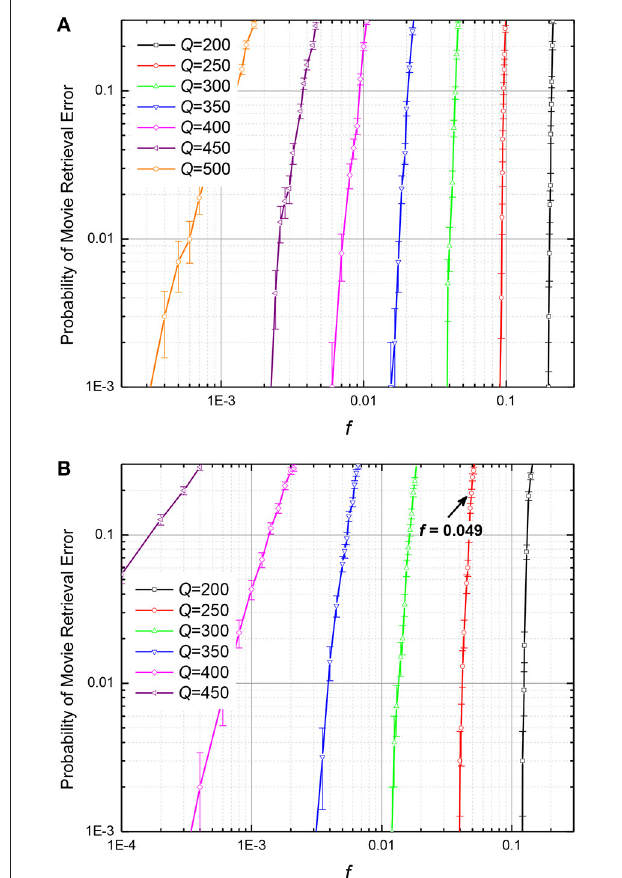
FIGURE 10 | The probability of movie retrieval error at: (A) the quadratic-programming recording, and (B) the discrete gradient-descent recording, as functions of the fraction f of wrong (randomly flipped) binary pixels in the input frame, for M 440. The arrow shows the point with = f 0.049, which corresponds to the case illustrated in Figure 12 . The error = bars represent standard deviation of the mean based on 1,000 simulations (10 randomly generated movies, 100 tests per